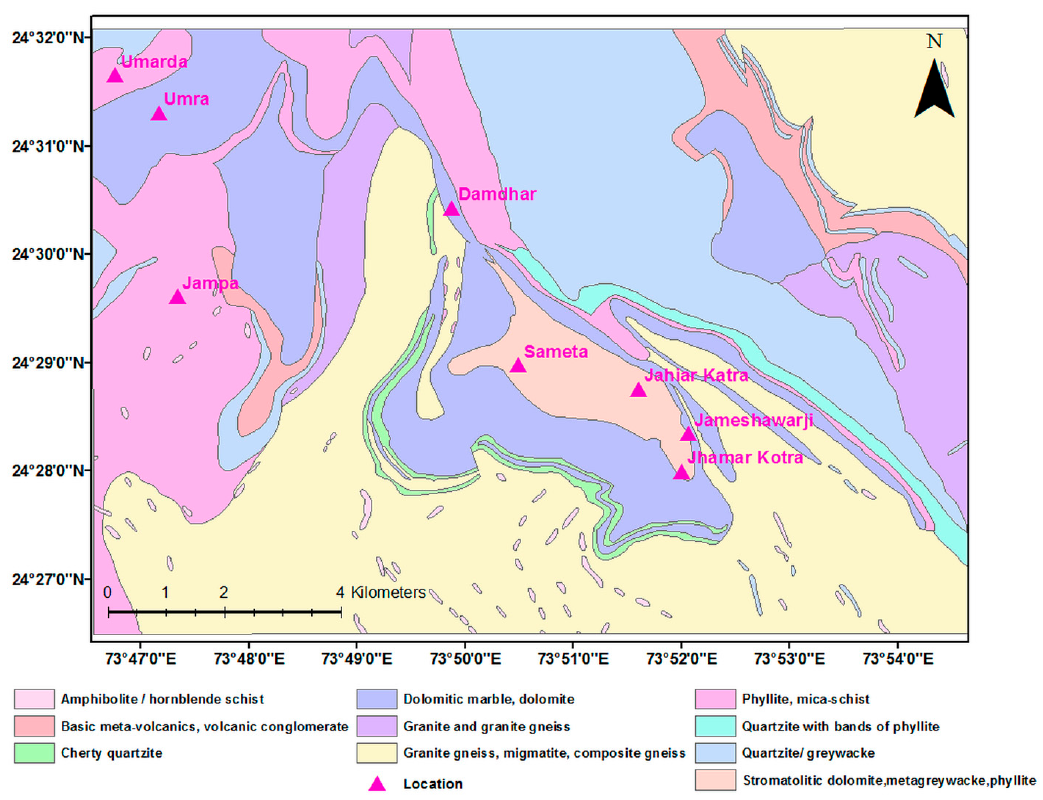
Figure 2. Lithological Map of the area (Source: Geological Survey of India (GSI); Unpublished). Triangles are important locations where phosphorites are exposed.